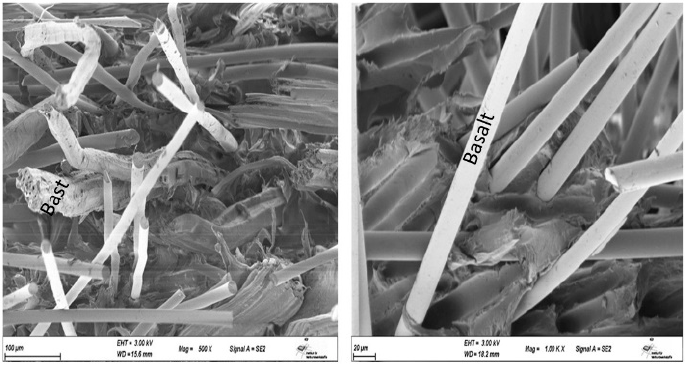
Figure 9. SEM Analysis: Wide and close view of tensile fracture surface of PP/25DBA/KEFL composite.